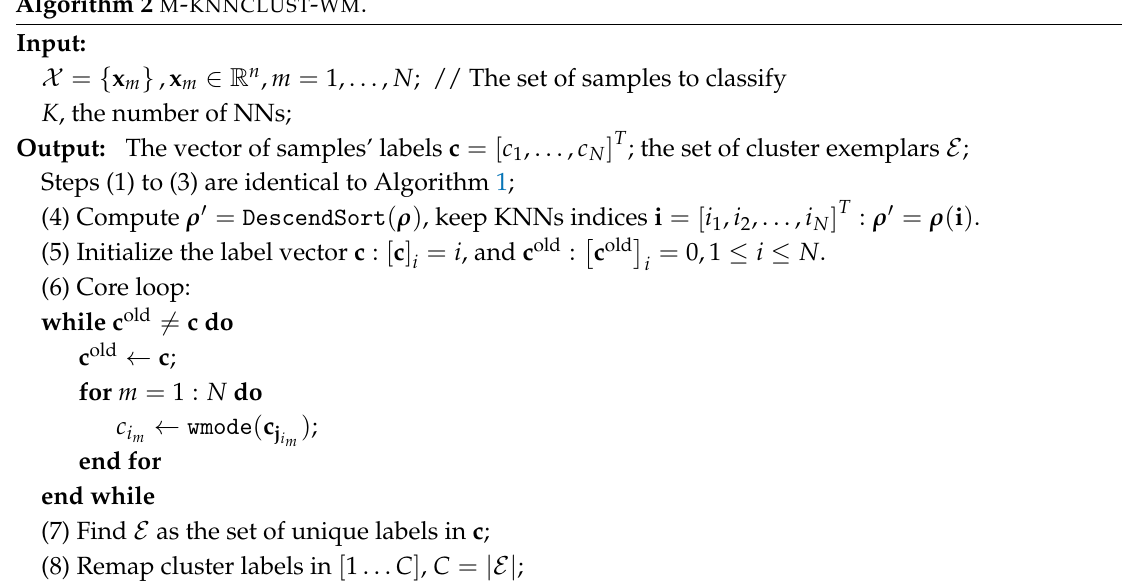
Algorithm 2 M - KNNCLUST - WM